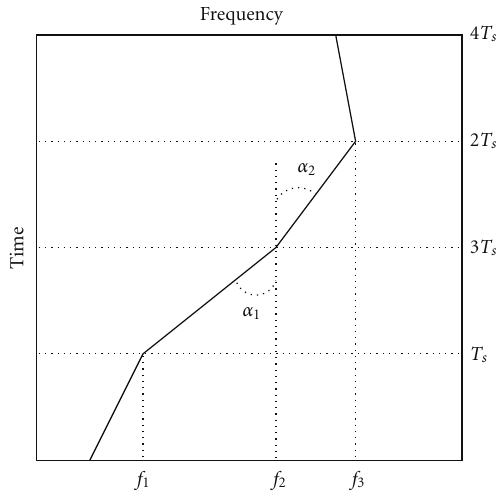
Figure 1: The epoch TFD split into 4 segments of length T s . The bold line represents the IF law of the signal.